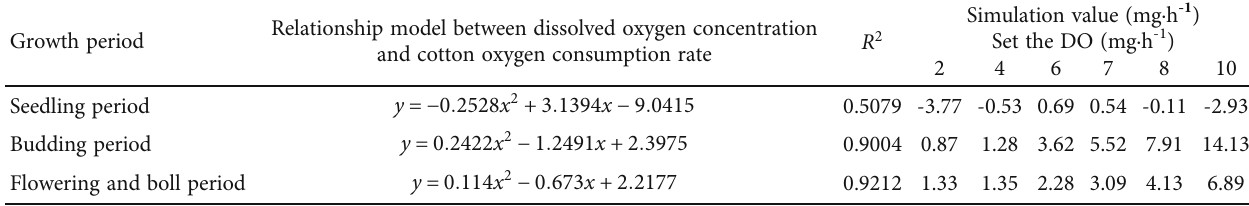
Table 4: Simulation table of immediate oxygen consumption rate per cotton